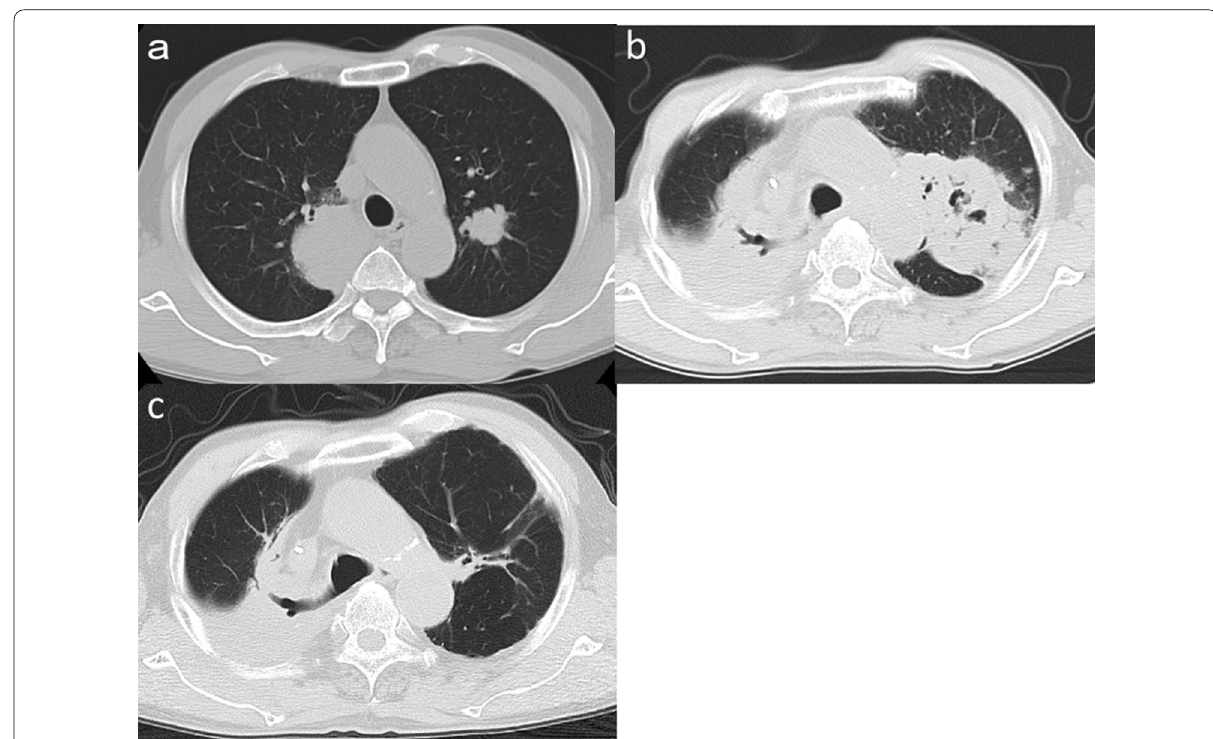
Fig. 2 Chest computed tomography findings. a Pretreatment, masses of size 5.2 upper lung lobe. b Before nivolumab, the mass in the left upper lobe grew up to 7.7 disappeared. An atelectasis remained in the right upper